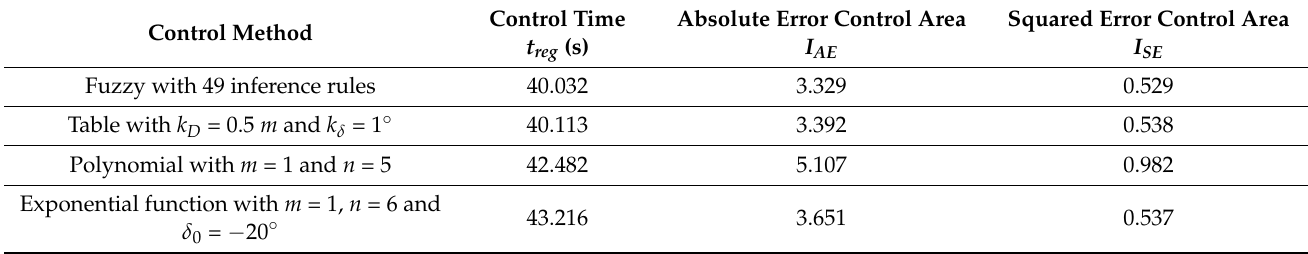
Table with k D = 0.5 m and k δ = 1 ◦ Polynomial with m = 1 and n = 5 Exponential function with m = 1, n = 6